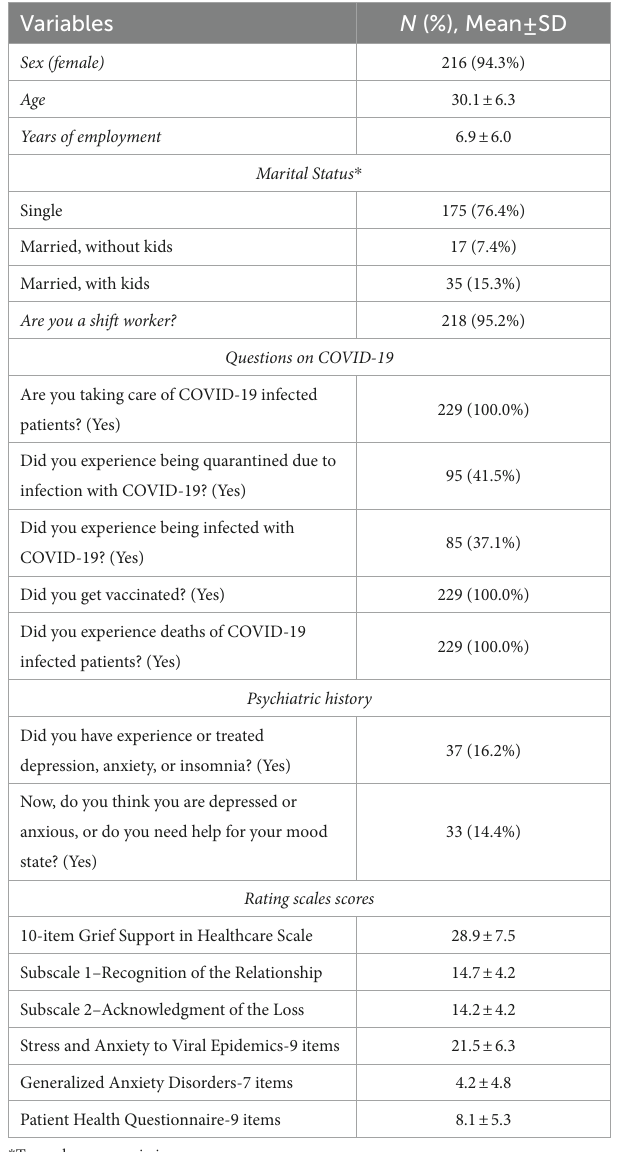
TABLE 1 Clinical characteristics of participants ( N =